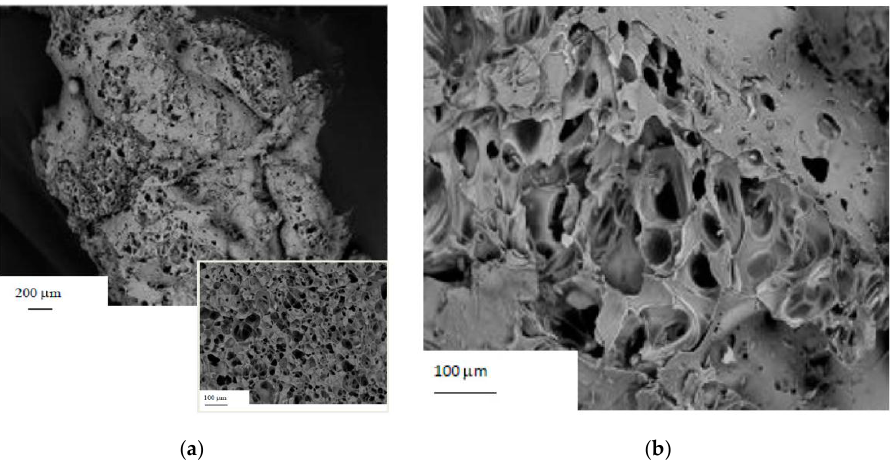
Figure 1. ( a ) SEM of a single perlite bead; inset: internal texture; ( b ) perlite external bead